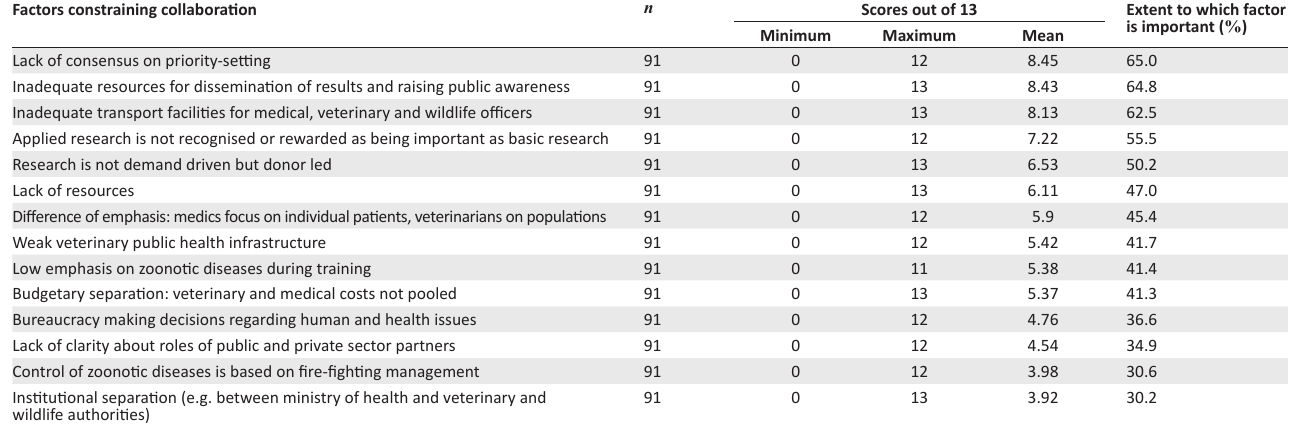
TABLE 3: Views on extent to which general factors constrain collaboration. Factors constraining collaboration